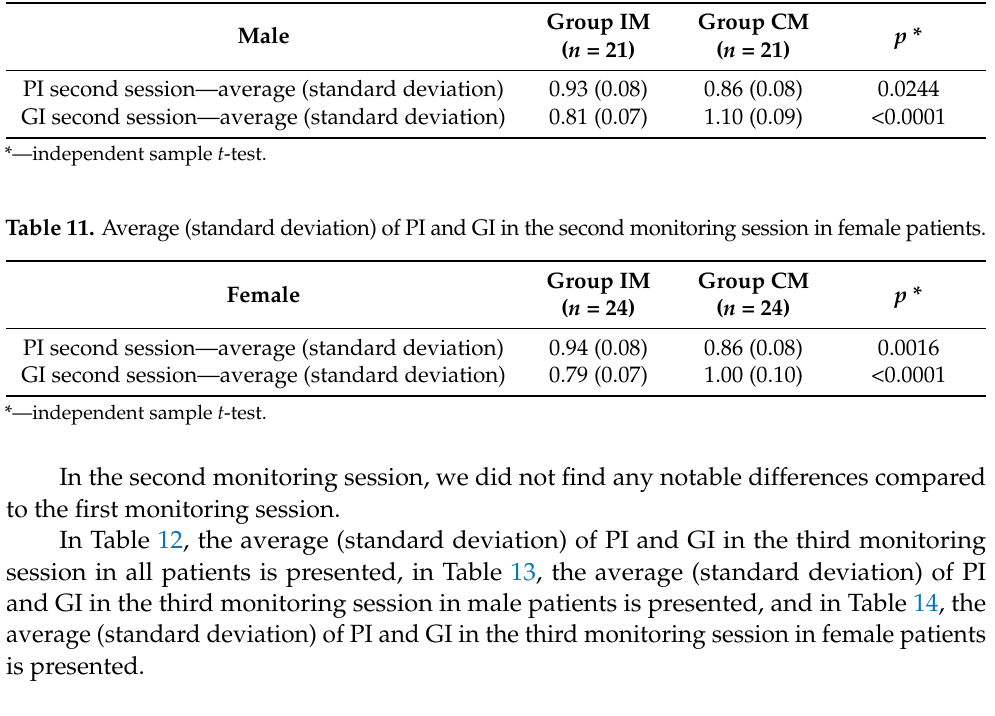
Table 12. Average of PI and GI in the third monitoring session in all patients. Total PI third session—median (interquartile range) 0.58 (0.57–0.62) 0.54 (0.45–0.58) <0.0001 *